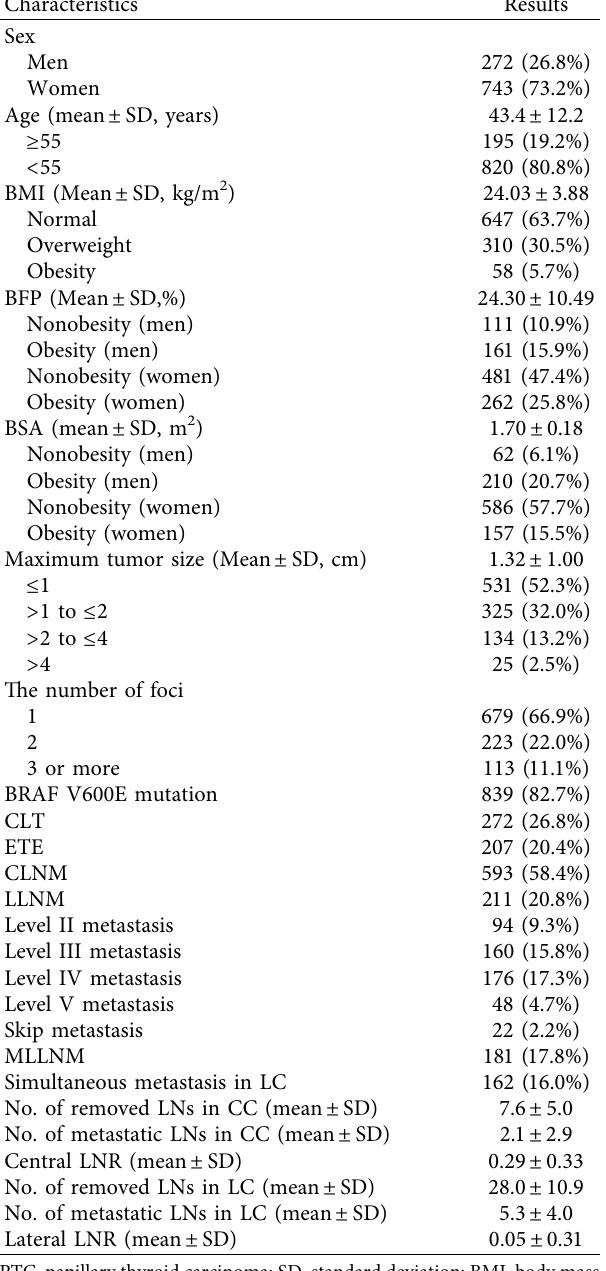
Table 1: Baseline clinical characteristics of patients with PTC.